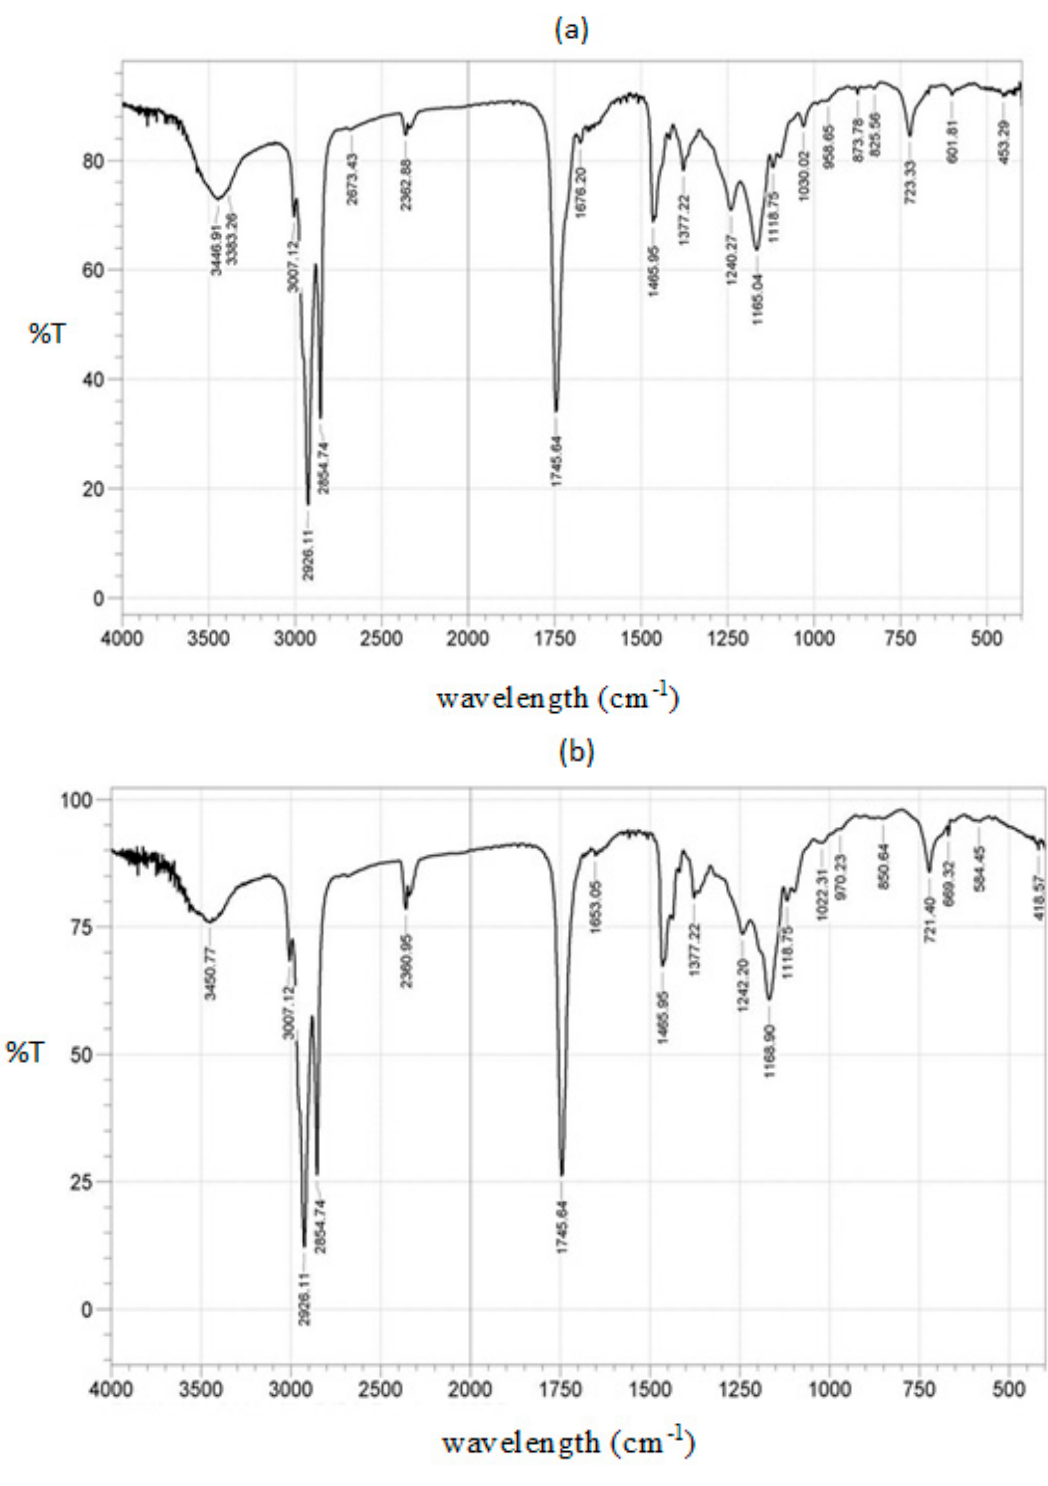
Figure 9. IR spectra; ( a ) HRNO and ( b ) HRNOB. Table 7. Properties of absorption peaks for HRNO and HRNOB.